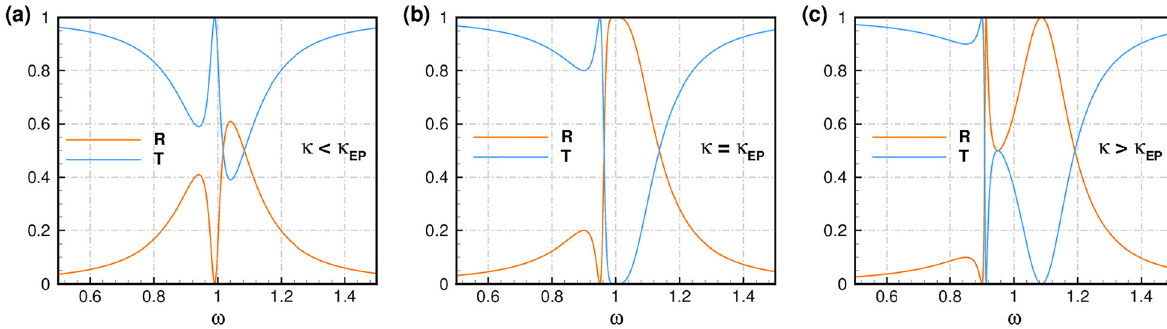
= 0 . 05 , r = 0 , t = 1 , κ = 0 . 05. EP e